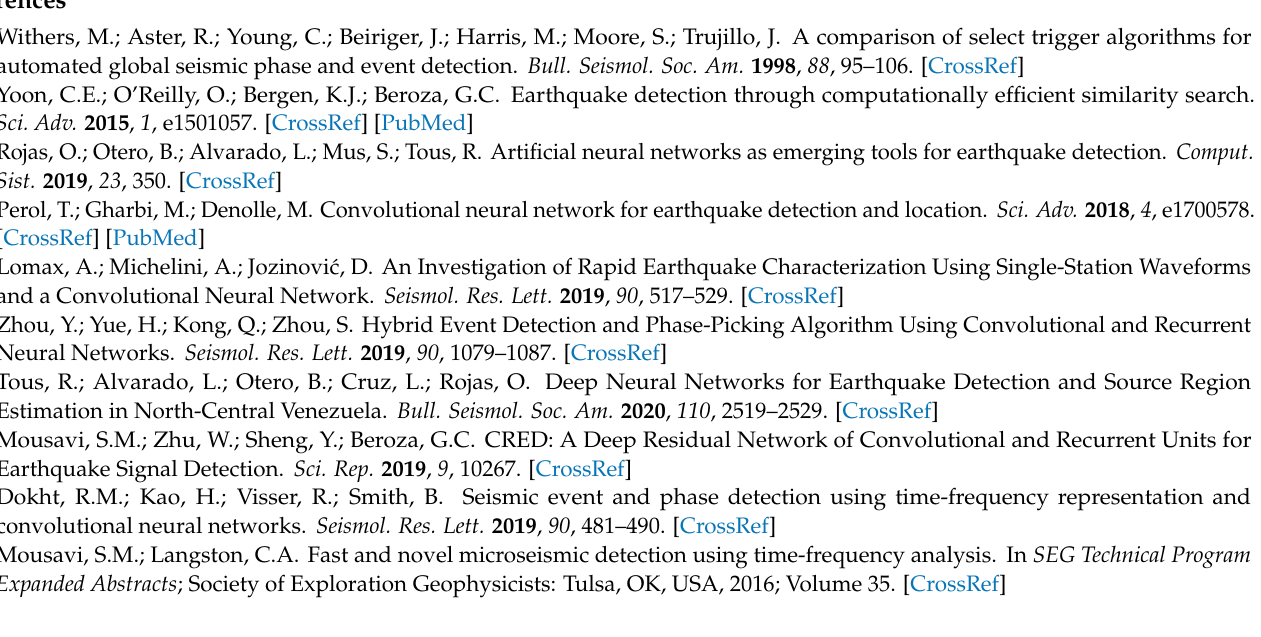
Figure S10: A comparison of receiver operating characteristic curves, all the representations and AlexNet, ResNet50 and VGG16 architecture; Figures S11–S19: A comparison of receiver operating characteristic curves of VGG16, ResNet50, AlexNet and the base model for each of the nine time- frequency representations separately; Figure S20: Two seismogram instances from the LEN-DB dataset, depicting an event (earthquake) and noise. The two instances are fairly close in terms of signal characteristics, which demonstrates the challenging nature of the classification